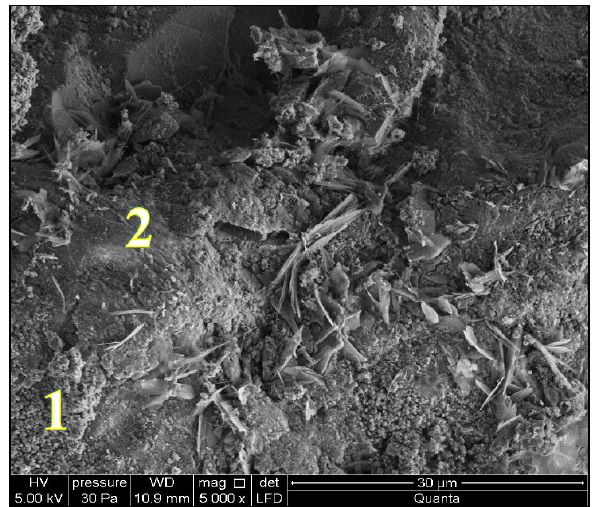
Figure 13: Microstructure of the D-series sample. 1. C-S-H phase. 2. Sand.